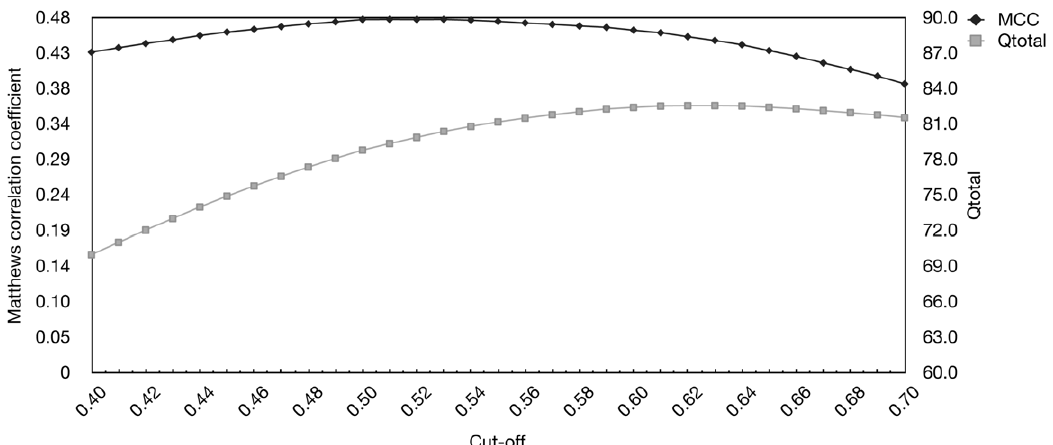
Figure 4. MCC and Q total as function of the cut-off value. The figure shows MCC and Q total as function of the cut-off value. The values are obtained by cross-validation of the Cull-2220 dataset. The X-axis is the threshold for a positive prediction of a b -turn. Y-axis to the left is the Matthews correlation coefficient and to the right Q total values.